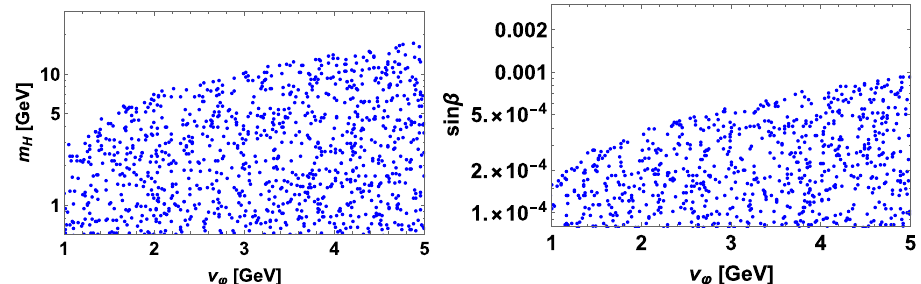
Fig. 1 Allowed region on { v ϕ , m } and { v ϕ , sin β } H